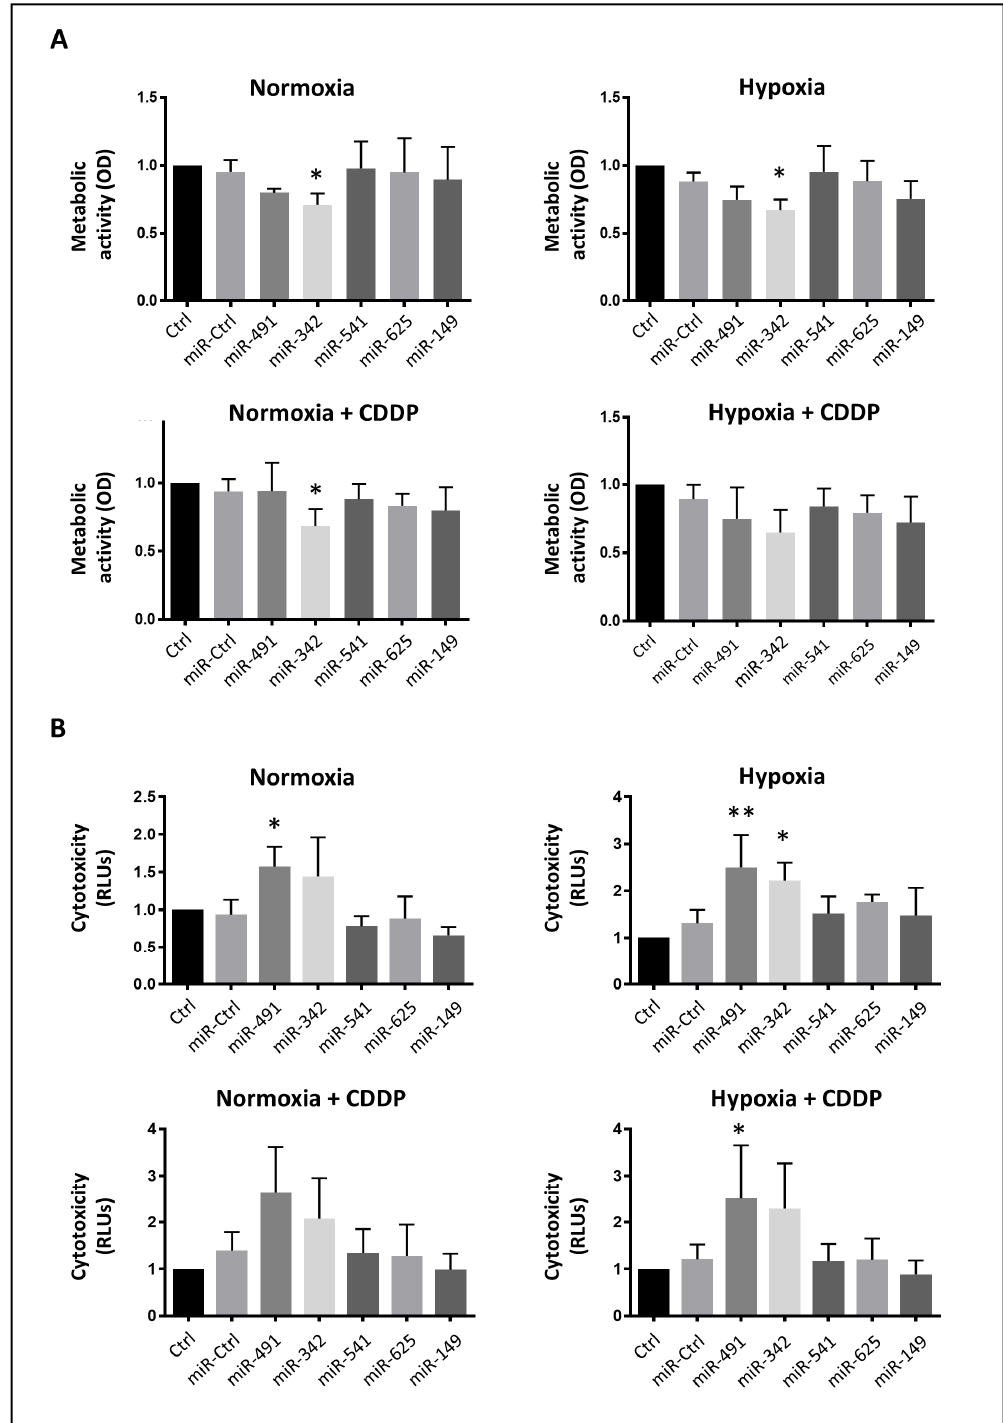
Figure 2. Analysis of the cytotoxic and antimetabolic effects of miRNAs on SW1353 cells. SW1353 cells were cultured under normoxia or hypoxia. They were transfected 24 h after seeding with 20 nM of miR-Ctrl, miR-491-5p, miR-342-5p, miR-541-5p, miR-625-5p or miR-149-5p. The treatment with CDDP (1 µg/mL) was performed 48 h post-transfection for 24 h. ( A ) The metabolic activity of cells was evaluated 72 h post-transfection and expressed as the mean optical density (OD) ± SD of five independent experiments. ( B ) The cytotoxicity of the miRNAs was evaluated 72 h post-transfection and expressed as the mean relative luciferase units (RLU) ± SD of four independent experiments. The significance of the results between miR-Ctrl and miRNA-treated cells was assessed using one-way ANOVA (*: p < 0.05, **: p < 0.01).